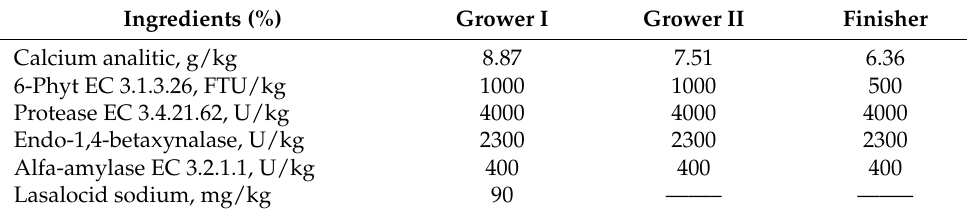
Table 1. Cont. Ingredients (%) Grower I Grower II Calcium analitic, g/kg